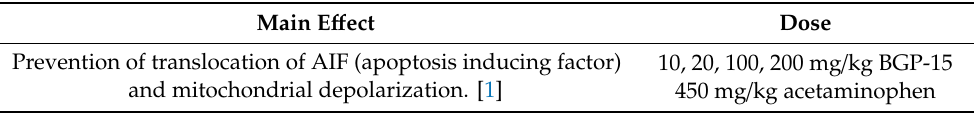
Table 5. Summary of the investigation related to the e ff ect of BGP-15 in paracetamol-induced cell